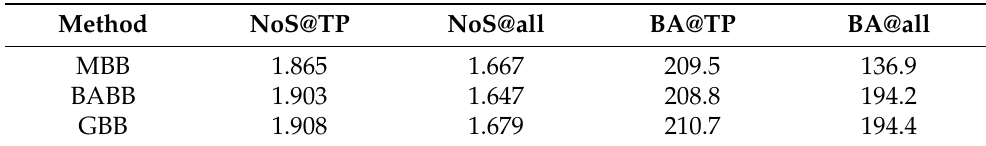
Table 7. NoS and BA estimation evaluation